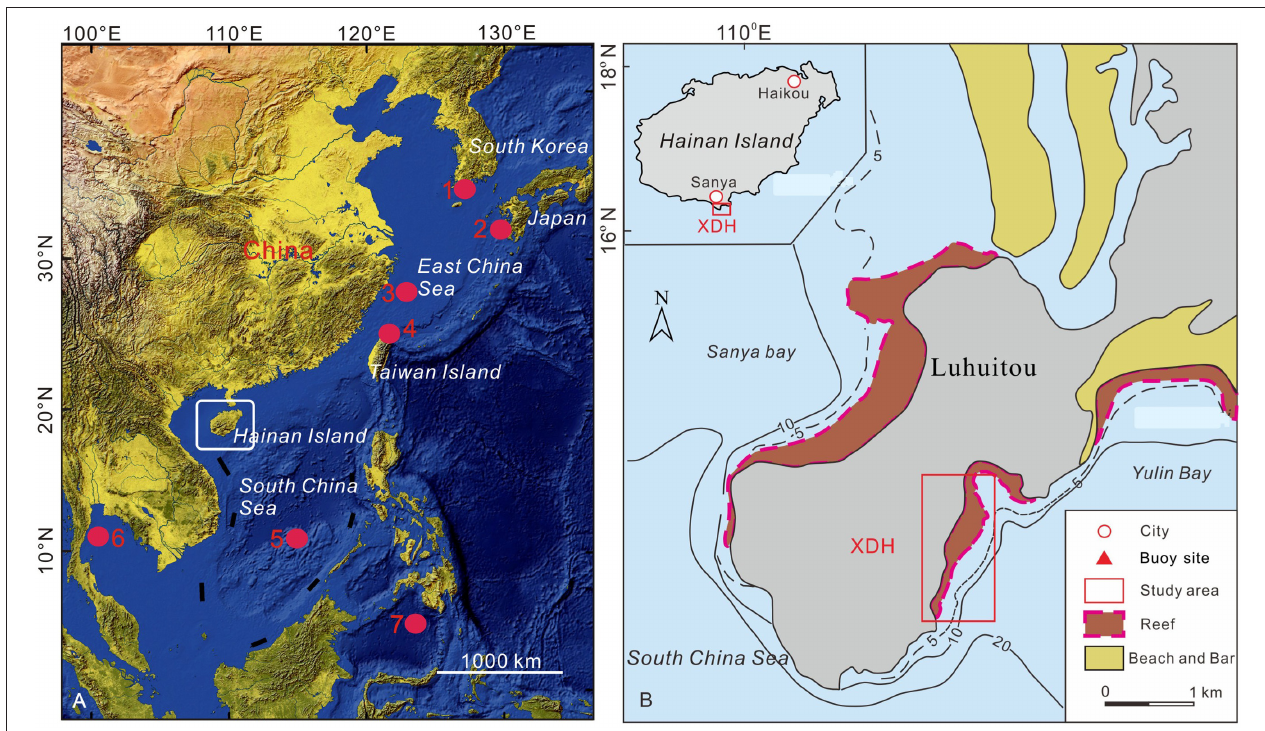
FIGURE 1 | (A) Location of Hainan Island in the northern South China Sea. Shown also here are the sites of (1) South Korea (Yang et al., 2017), (2) Kamikoshiki Island in Japan ( Woodruff et al., 2009), (3) East China Sea (Zhou X. et al., 2019), (4) Taiwan (Chen et al., 2012), (5) the Yongshu Reef of southern SCS (Yu et al., 2004), (6) Gulf of Tailand (Terry et al., 2018), and (7) core MD98-2181 (Stott et al., 2004), where additional information was used in this study. (B) The coastline of Luhuitou showing the maximum extent of reefs and the study site at Xiaodonghai [modified from Zhao et al. (1983), Zhang (2001)].